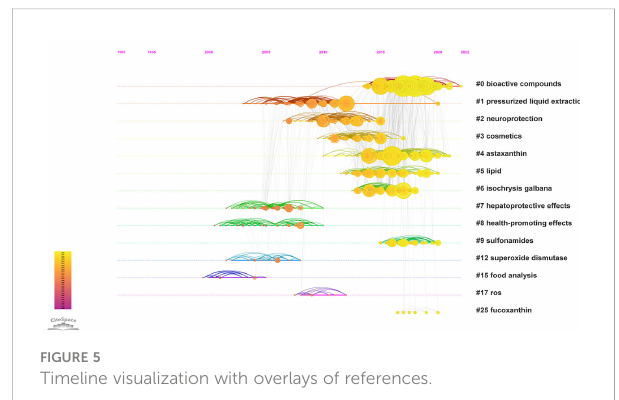
FIGURE 5 Timeline visualization with overlays of